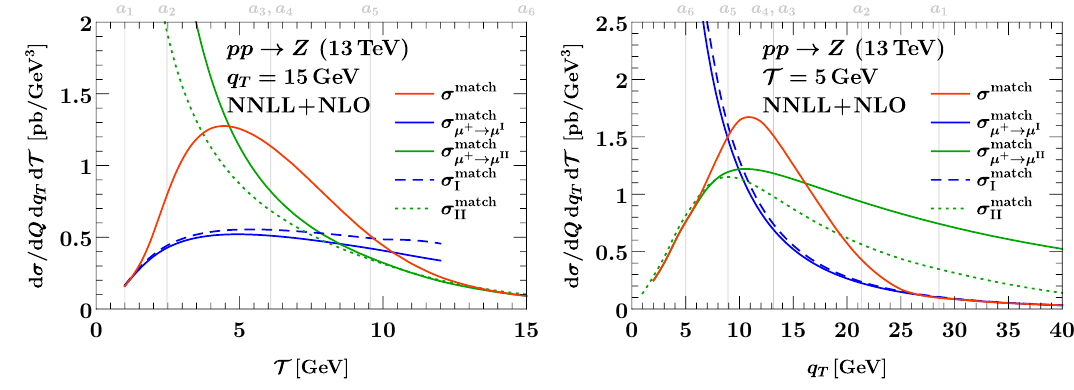
Figure 19 . Slices of the double-di(cid:11)erential Drell-Yan cross section at q T = 15 GeV (left) and T = 5 GeV (right). The solid red, dashed blue, and dotted green curves are identical to the central results in (cid:12)gure 18. The solid blue and green curves depict the SCET I and SCET II limits of our fully resummed result, given in eqs. (3.12) and (3.14). The thin vertical lines indicate the transition points a i described in section